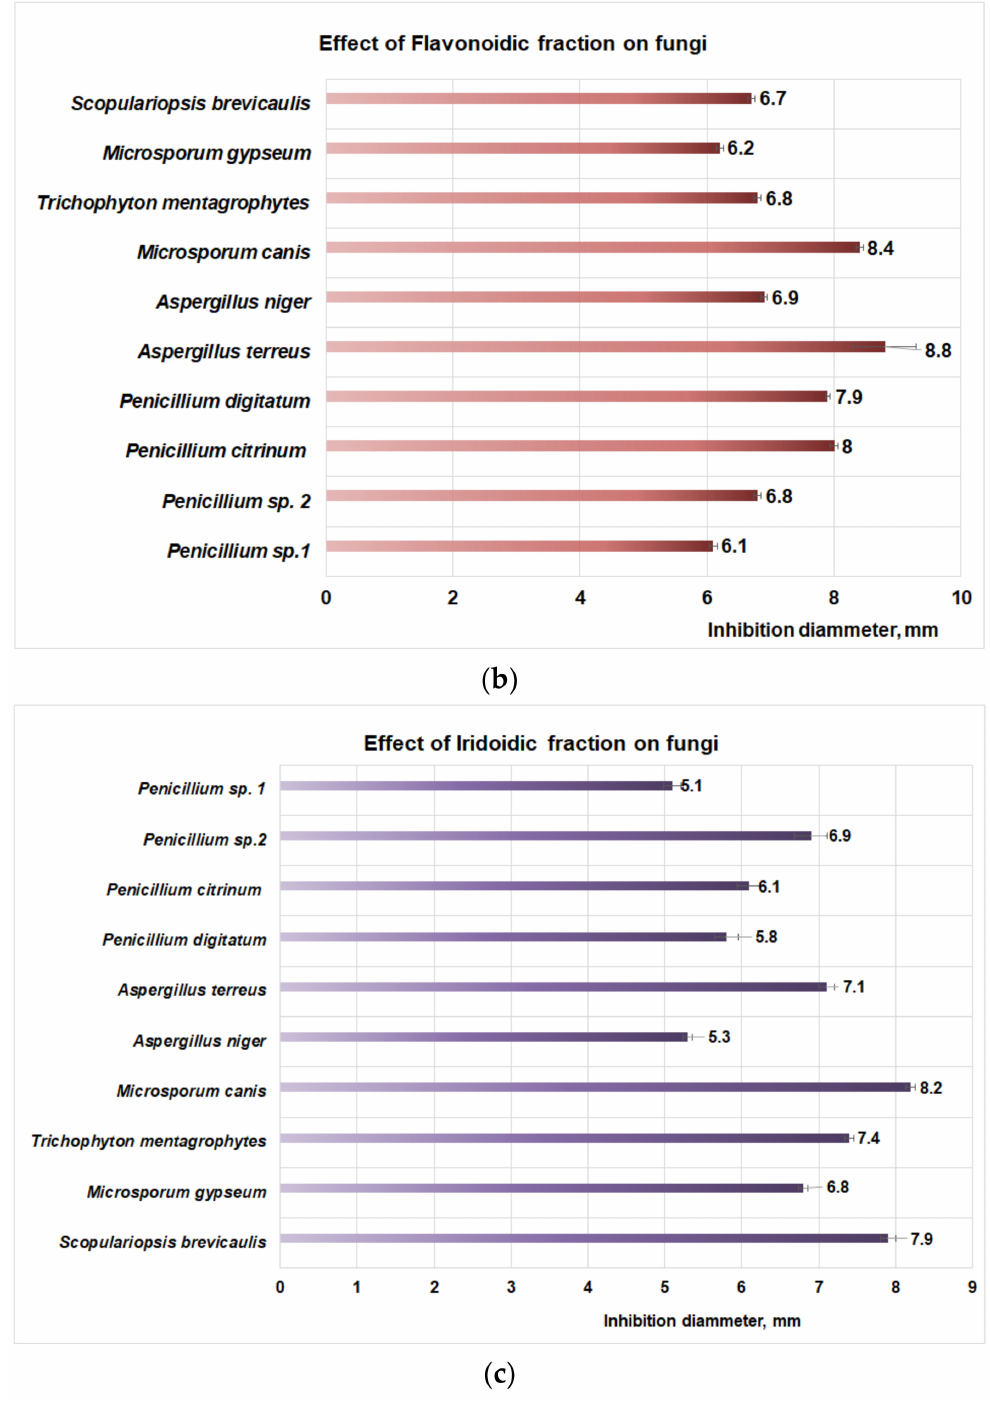
Figure 4. ( a ) The effect of polysaccharidic fraction on different fungal strains. ( b ) Effect of flavonoidic fraction on different fungal strains. ( c ) Effect of iridoidic fraction on different fungal